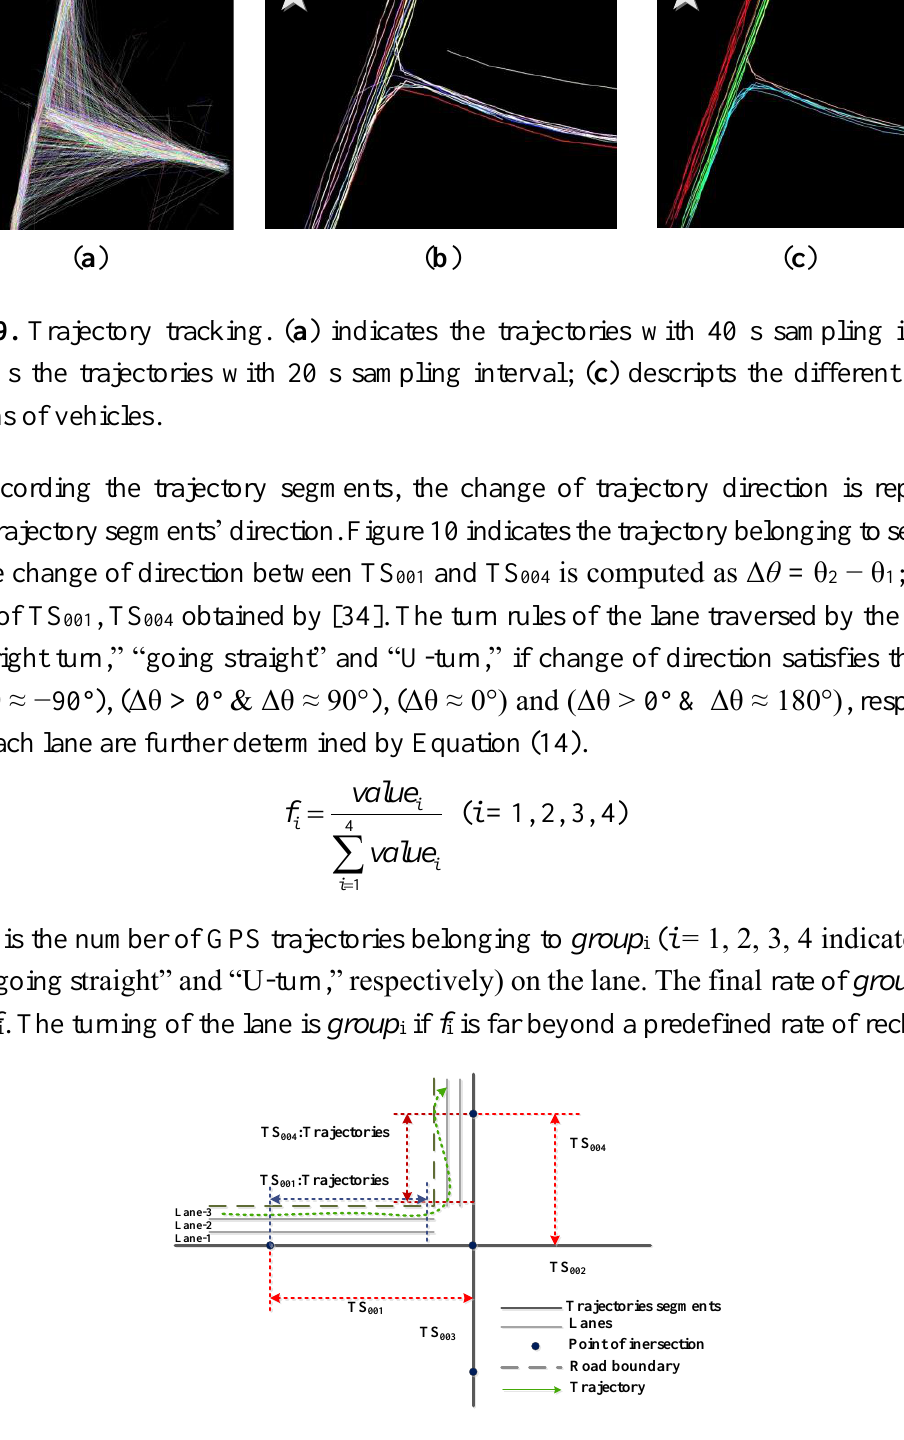
Figure 10. Intersection turns: left turn, right turn and U-turn